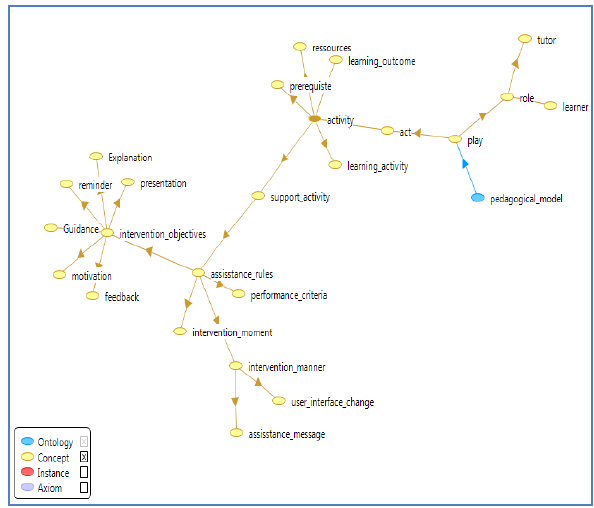
Figure 4 . The pedagogical model ontology Testing: WSMO contains an integrated Stratified IRIS reasoner to query the ontology described in WSML. Figure 5 shows examples of queries applied to our ontology to define characteristics of a sensitization assistance rule that is applied to learners with unsatisfactory ability.